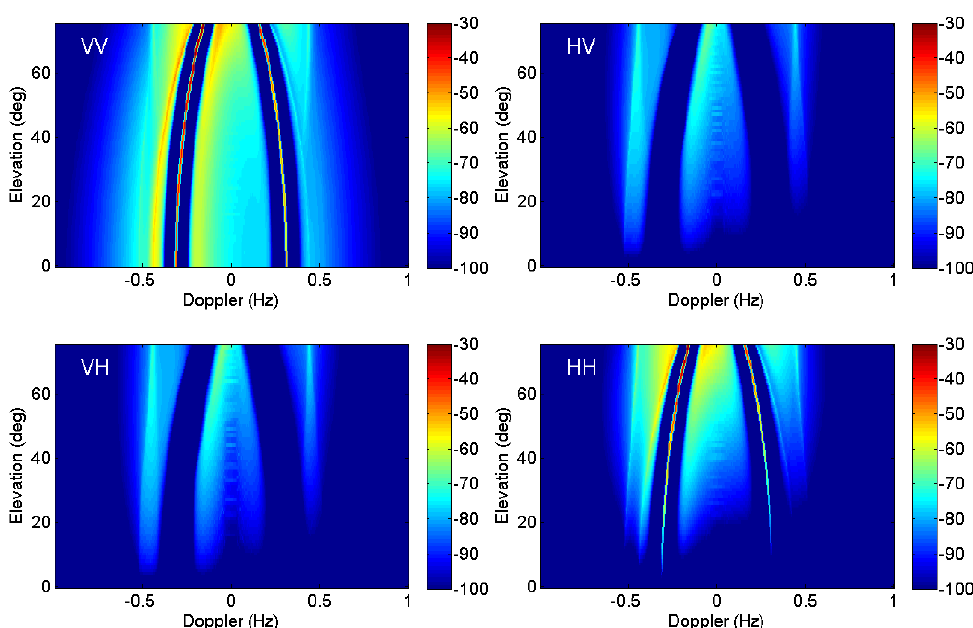
Figure 11. Magnitudes of the elements of the power scattering matrix for similar parameters to those used in Figure 10. Colour bars measure power spectral density in dB/Hz.